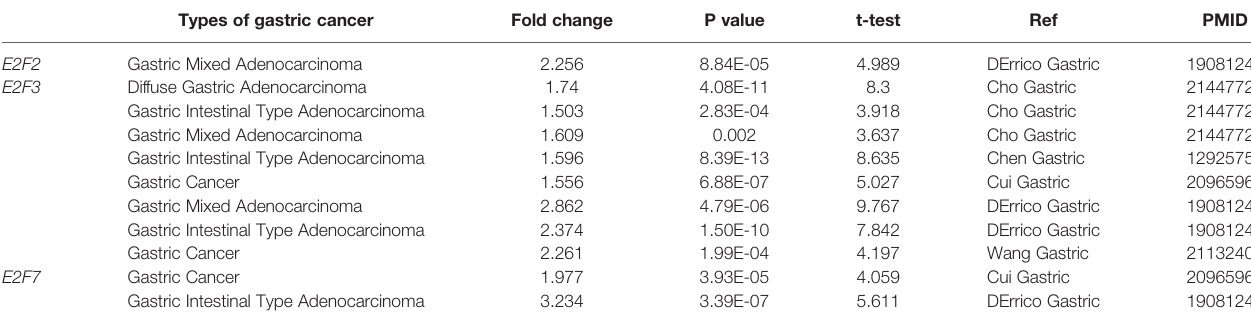
TABLE 2 | Changes of E2Fs mRNA levels between different types of GC and normal gastric tissues (ONCOMINE). Types of gastric cancer Fold